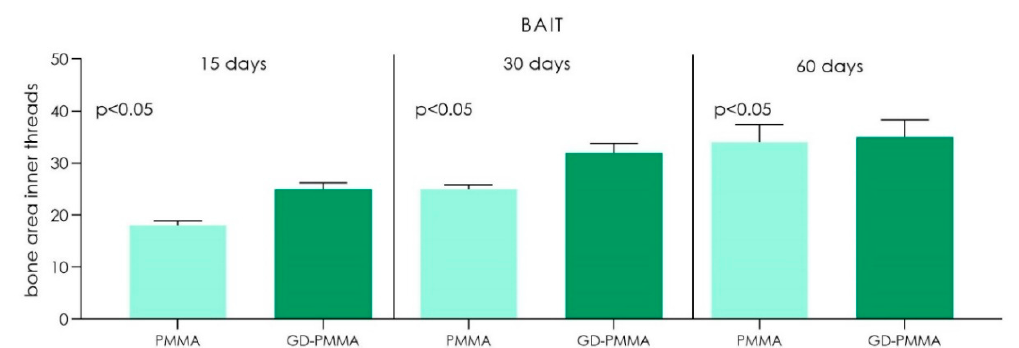
Figure 7. Chart of volume of bone area inner threads (BAIT) between the PMMA implants group and GD-PMMA implants group. A significant difference was detected between PMMA and GD-PMMA groups at 15, 30 and 60 days (Kruskal Wallis followed by the Bunn’s test).